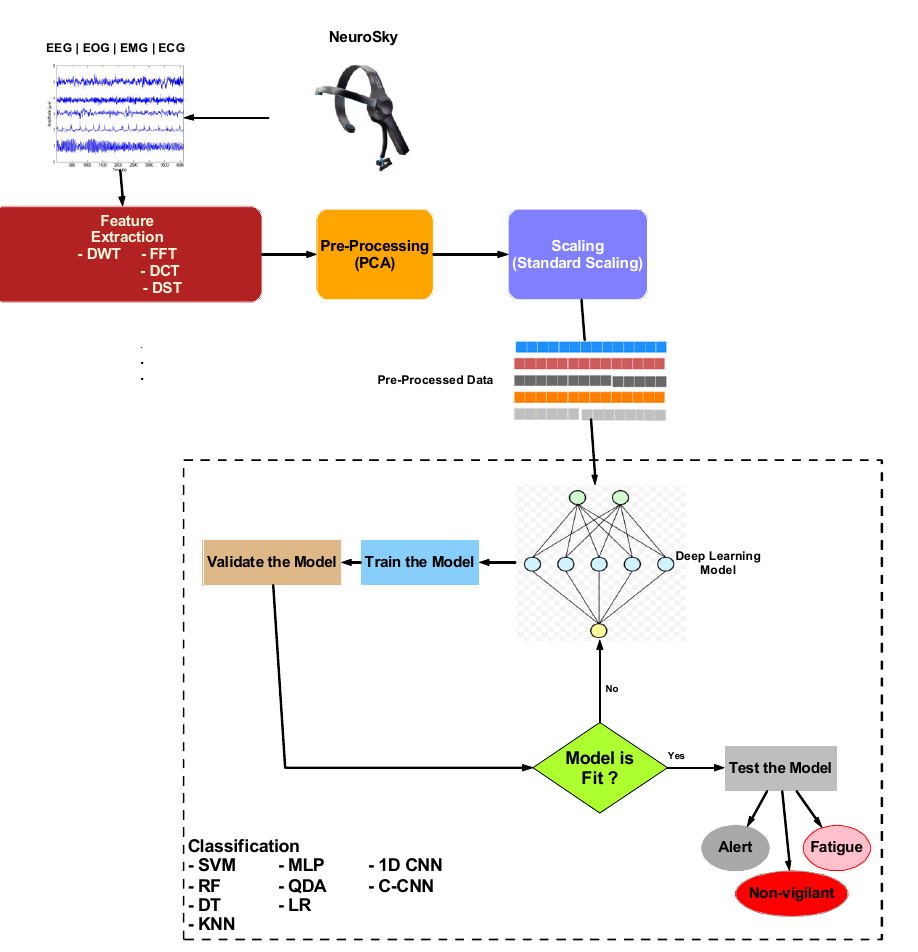
Figure 2. Proposed system for detecting fatigue. Table 1. Sample of iterations for Hyperparameter Optimization. Hyper